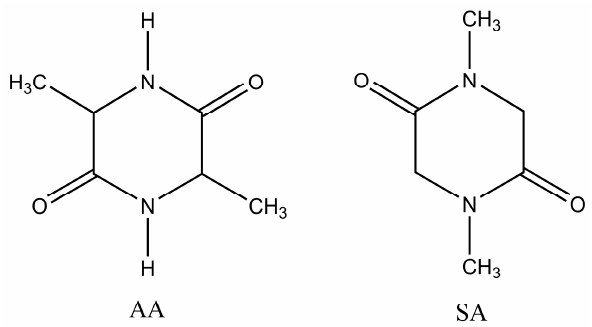
Figure 1. Diketopiperazines studied in this work. Scans of the spectra indicated their presence in the region from 400 to 4000 cm − 1 . The absorption frequencies of the C=O area was analyzed. The absorption frequencies of the C=O group of sarcosine anhydride in the environment of organic solvents are presented in Figure 2.